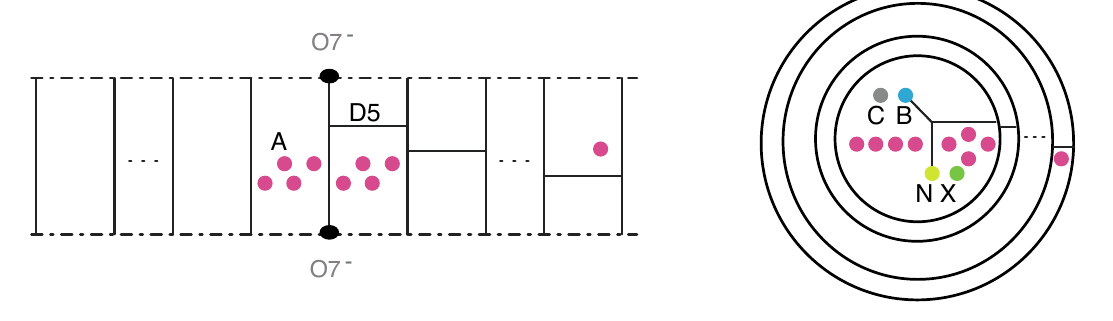
Figure 43 . Left: 5d brane con(cid:12)guration for the quiver [1 A ; 8] (cid:0) SU(1) (cid:0) SU(1) (cid:0) (cid:1) (cid:1) (cid:1) (cid:0) SU(1) (cid:0) [1]. Right: splitting the O 7 (cid:0) plane gives 5-brane loops which are denoted as circular loops.